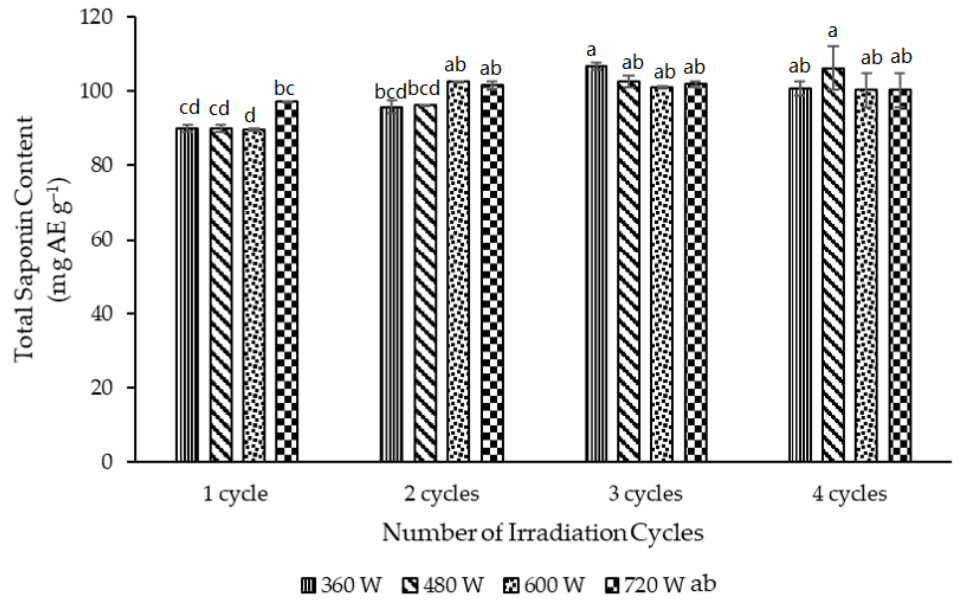
Figure 4. Effect of microwave power and irradiation time (cycles) on the TSC of the full-fat Gac seed kernel powder measured using MAE. The values are the means of three replicates for each extraction and columns not sharing the same superscript letter are significantly different at p < 0.05.